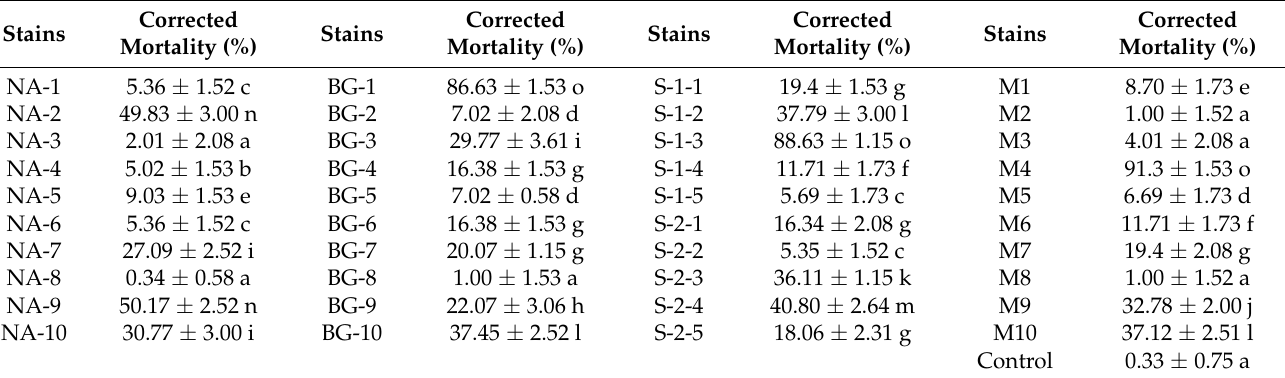
Table 1. Nematicidal activities of cell-free culture of different strains.